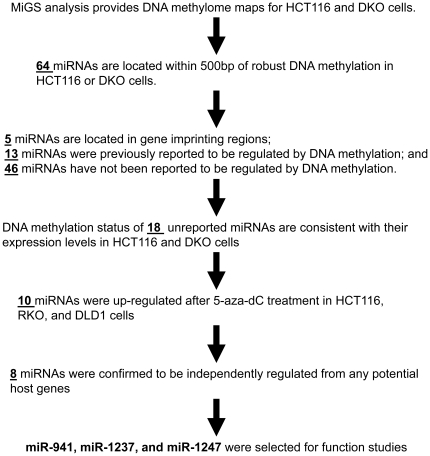
Overview of the screening approach performed in this study.